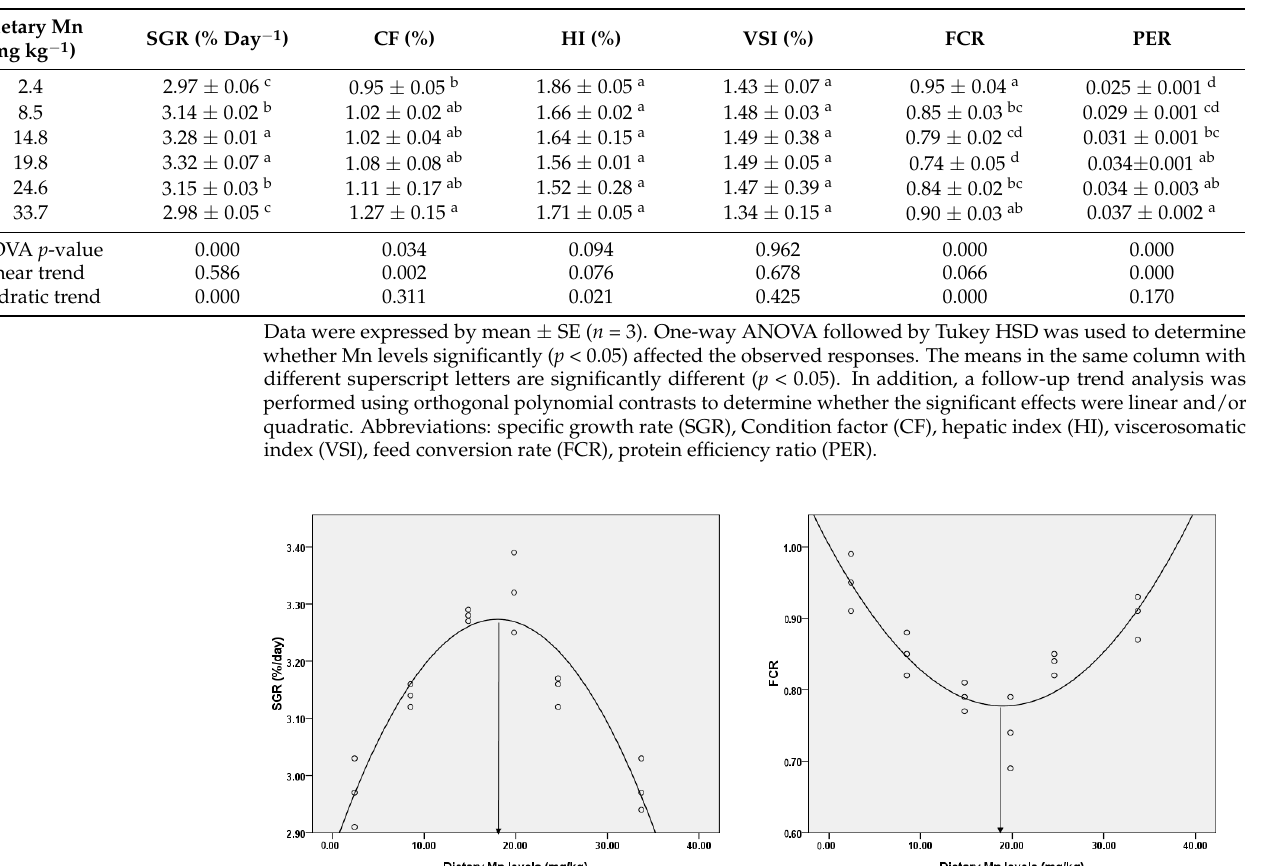
Table 3. The growth performance and feed utilization of post-larval coho salmon fed a diet with different levels of manganese.